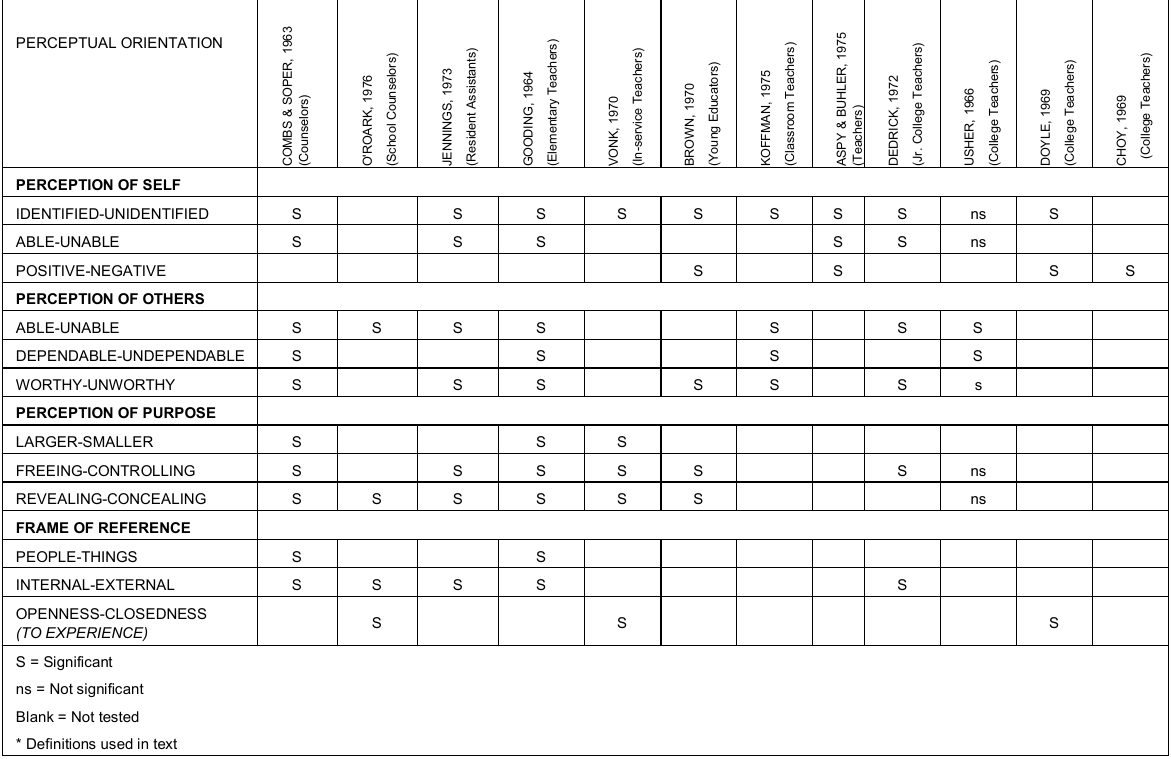
* Definitions used in